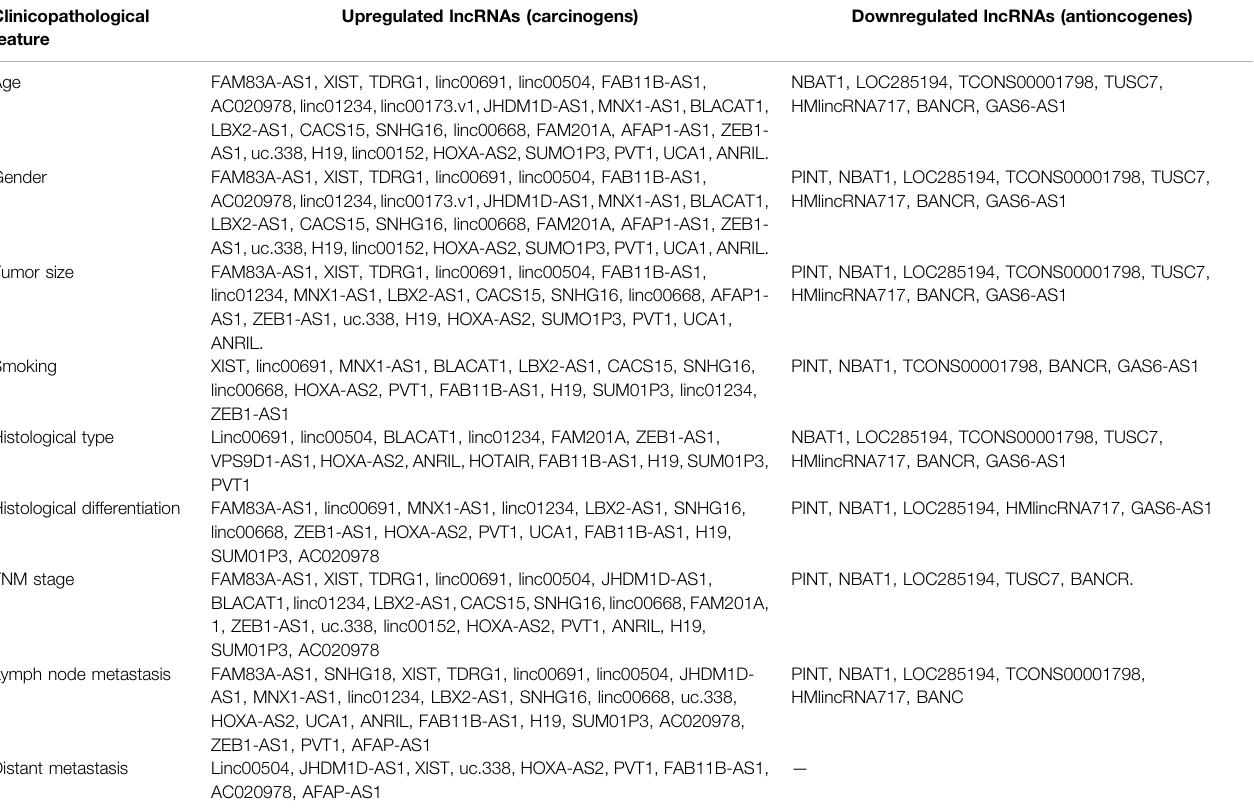
TABLE 2 | Summary of lncRNAs related to clinicopathological features of